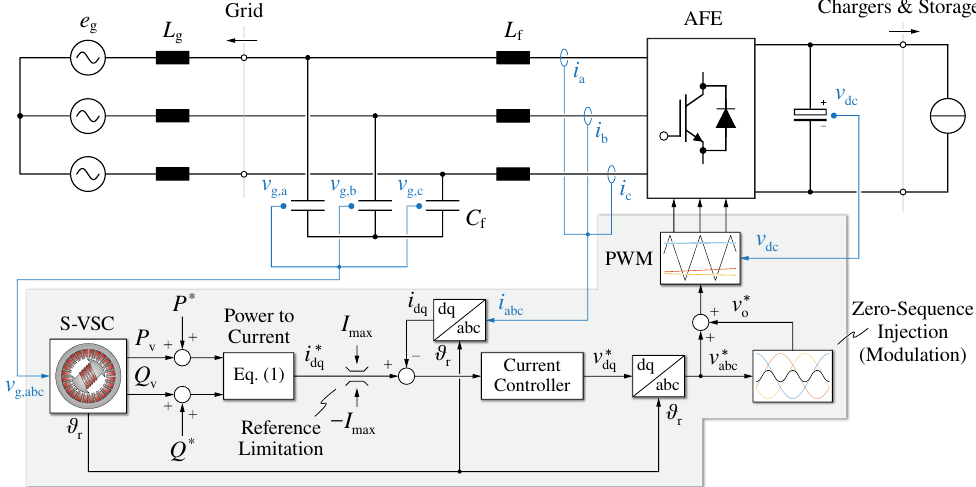
Figure 6. General schematic overview of the proposed ultra-fast charging (UFC) station active front-end (AFE) control